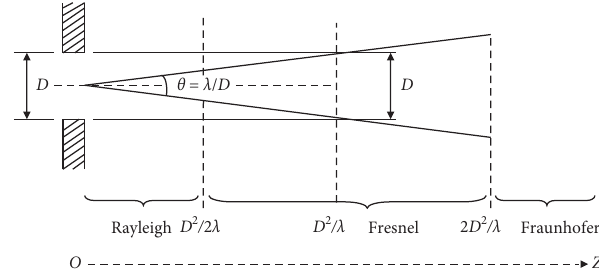
Figure 4: Three radiation regions for the field diffracted from a radiating aperture. Note that D is the radius of the aperture ( D � 2 A ). Source: Ref. [23], figure 7.42.